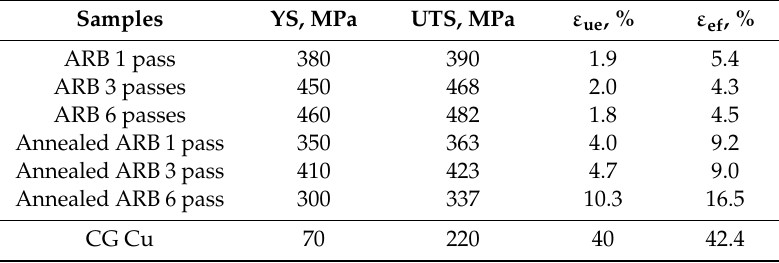
Table3. Listofyieldstrength(YS),ultimatetensilestrength(UTS),uniformelongation ε ue , andelongation to failure ε ef of as-ARBed and as-annealed Cu